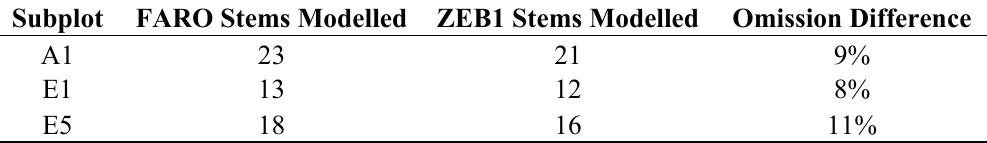
Table 3. Stem modelling results for ZEB1 against